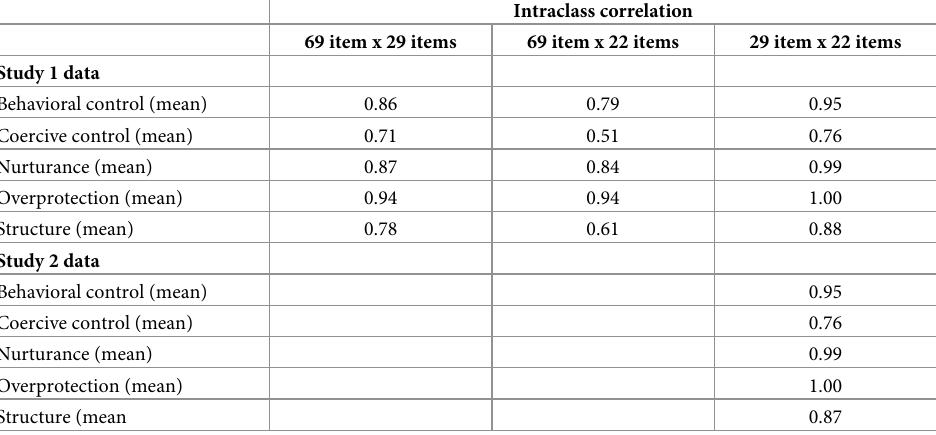
Table 3. Intra-class correlation between versions created using a different number of items for Study 1 and Study 2